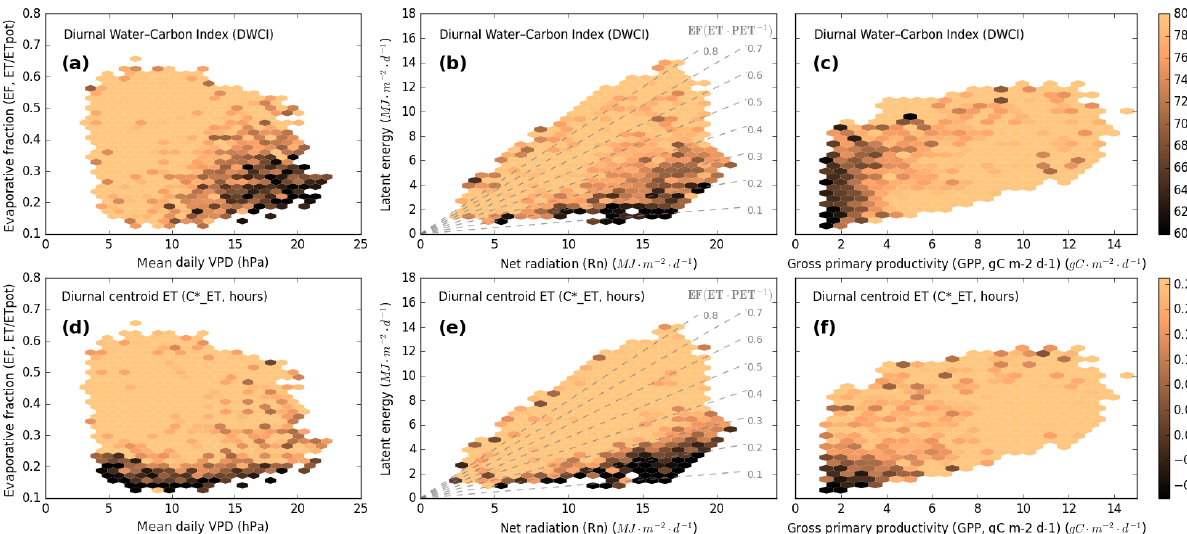
Figure 6. Mean DWCI (a, b, c) and C ∗ (d, e, f) with respect to evaporative fraction (EF) by vapor pressure deficit (VPD) (a, d) , latent ET energy (LE) by R n (b, e) and LE by GPP (c, g) . Note that DWCI of 0–100 indicates lowest–highest probability of diurnal carbon–water coupling and that C ∗ of − 1 to 1 indicates 1-hour morning-shifted to 1-hour afternoon-shifted ET. Points with high R n and low LE are ET associated with both low DWCI and C ∗ , indicating that both metrics are related to water limitations. Though both metrics are associated ET with low EF, DWCI shows a much higher response to atmospheric demand as measured by VPD, with C ∗ showing a very limited response. ET Both metrics, and DWCI in particular, show low values with high ET and low R n , though these points are also associated with over-closed energy balances (LE + H > R n ). Both metrics are associated with low GPP, but the C ∗ is restricted to both low GPP and ET, indicating that ET water and carbon can decouple over a wider range of water stress. This also holds when points with energy balance over-closed are excluded (data not